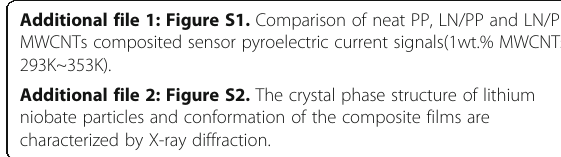
Additional file 1: Figure S1. Comparison of neat PP, LN/PP and LN/PP/ MWCNTs composited sensor pyroelectric current signals(1wt.% MWCNTs, 293K~353K). Additional file 2: Figure S2. The crystal phase structure of lithium niobate particles and conformation of the composite films are characterized by X-ray